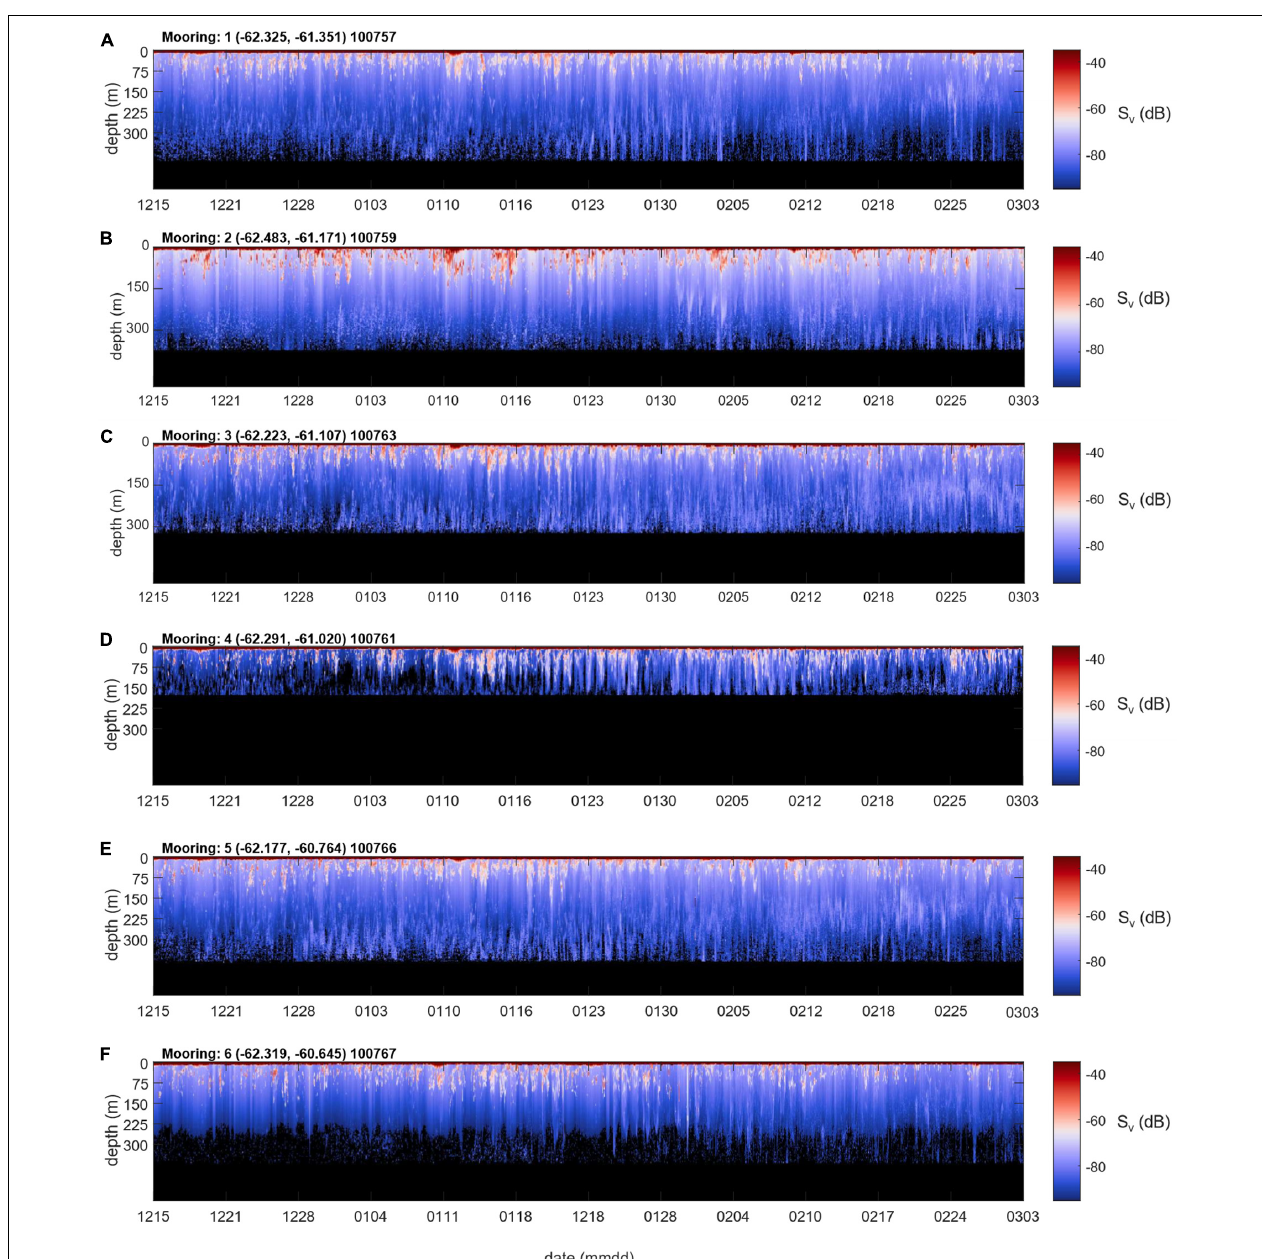
FIGURE 5 | Full series echograms of Sv by date (mmdd: two digit month and day) and depth from each mooring ( A–F correspond to Moorings